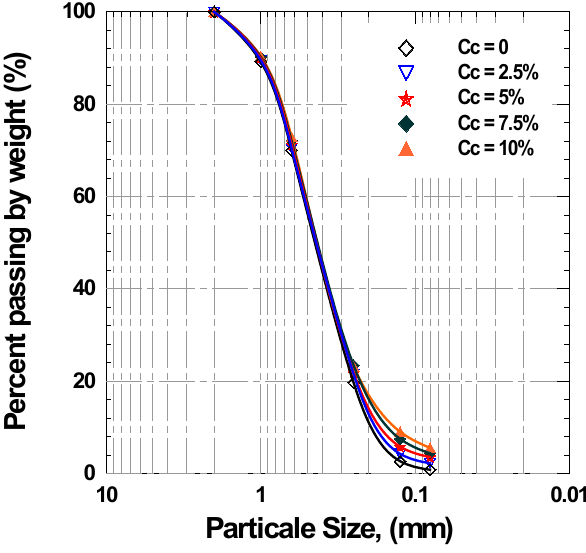
Figure 2: Grain size distribution curve of Chlef sand and cemented